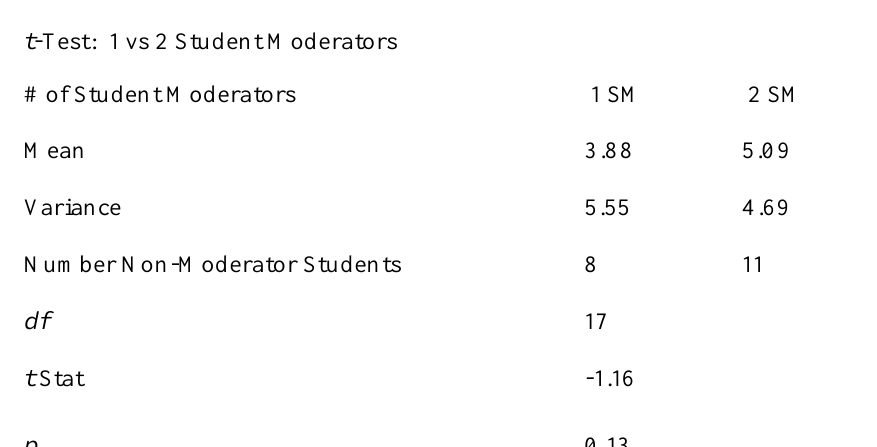
Student Non-Moderator Participation t -Test: 1 vs 2 Student